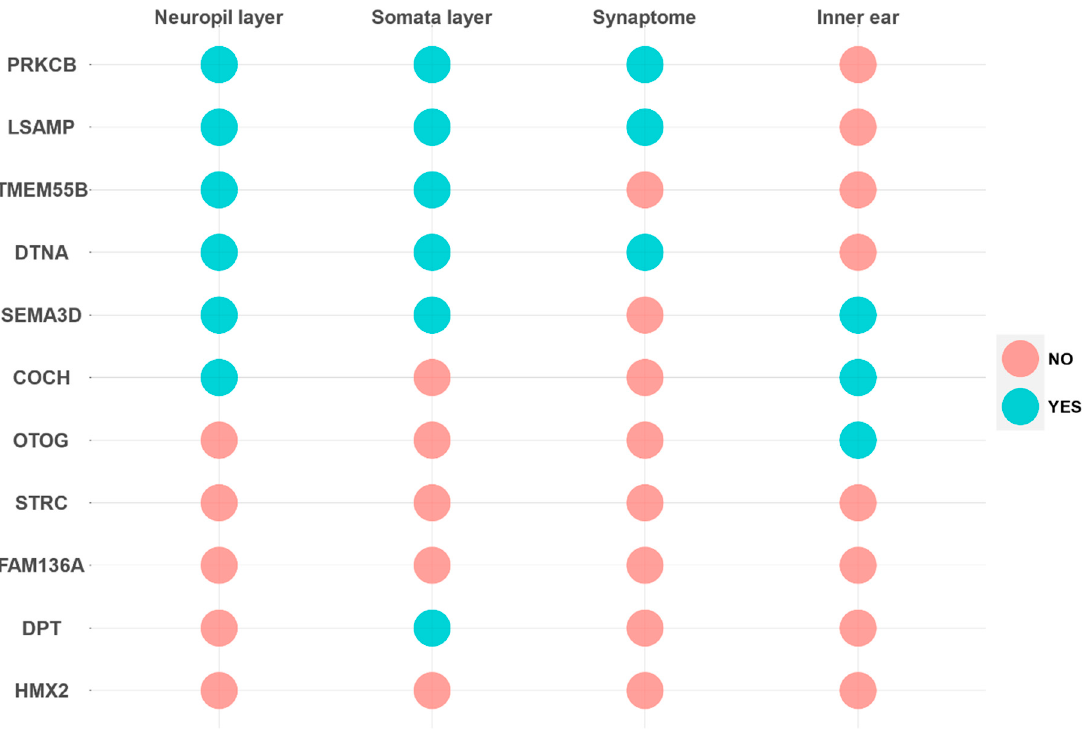
Figure 2. Summary of candidate FMD genes expressed in neural tissues and human inner ear databases, and in cyan genes that appear in the databases and in red genes that do not appear. Genes were identified in Neuropil layer and Somata layer of CAI Hippocampus in R. norvegicus (columns 1 and 2); genes that encode proteins of human synapsis (column 3) and preferentially expressed genes in the human inner ear compared to 32 other tissues (column 4).